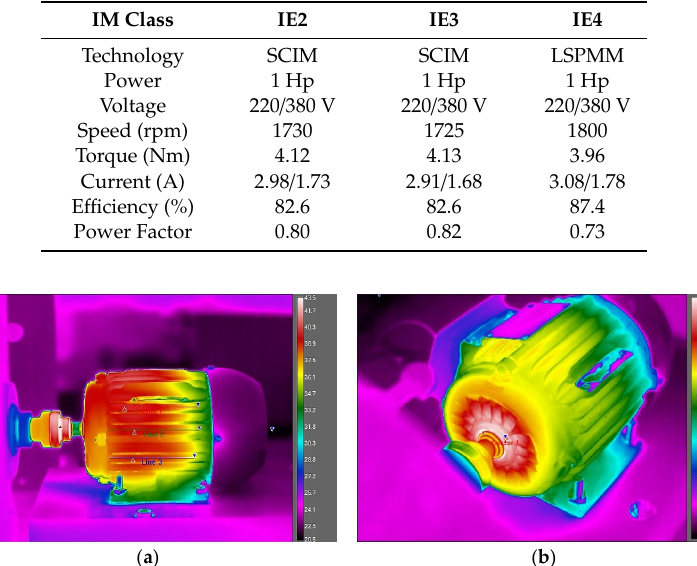
Figure 6. Flowchart of the methodology used to obtain the results from the measurements.